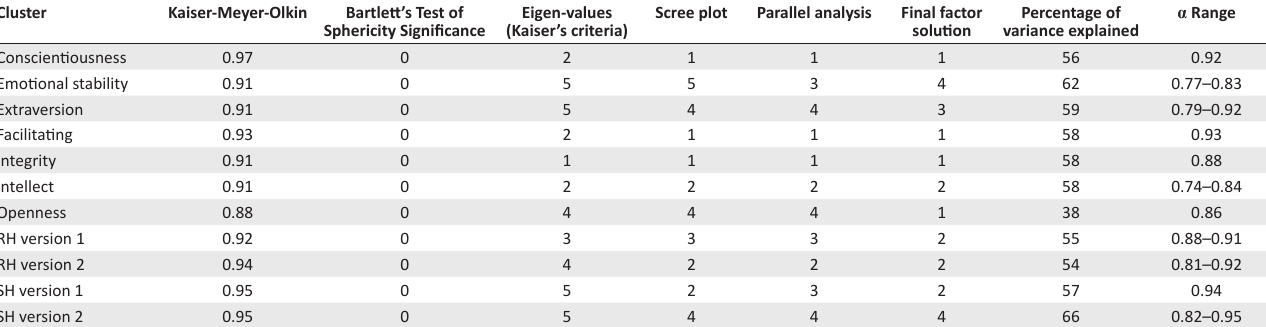
TABLE 5: Factorability of the correlation matrices and the number of factors retained for the South African Personality Inventory clusters.